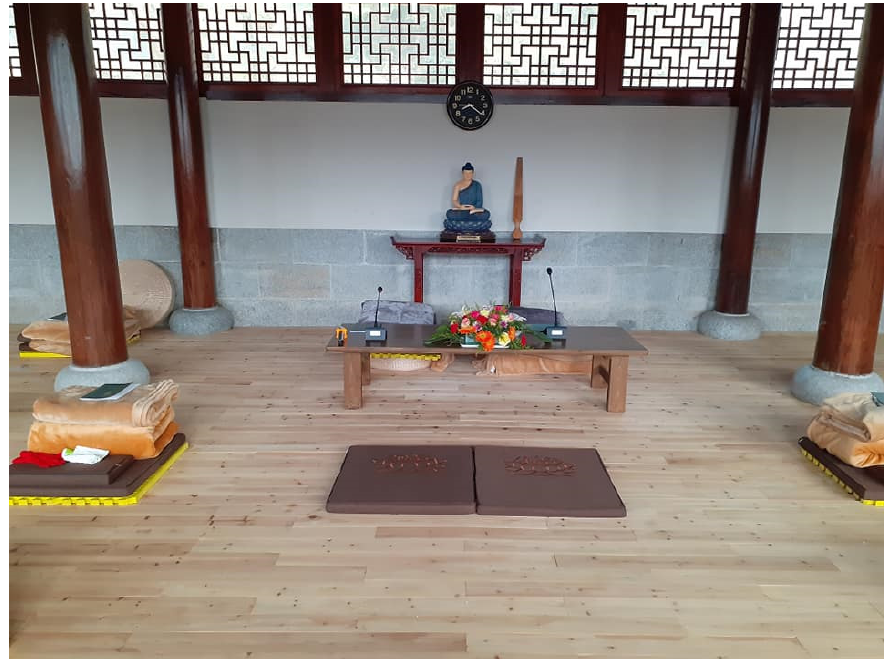
Figure 2. Fragrant sword.